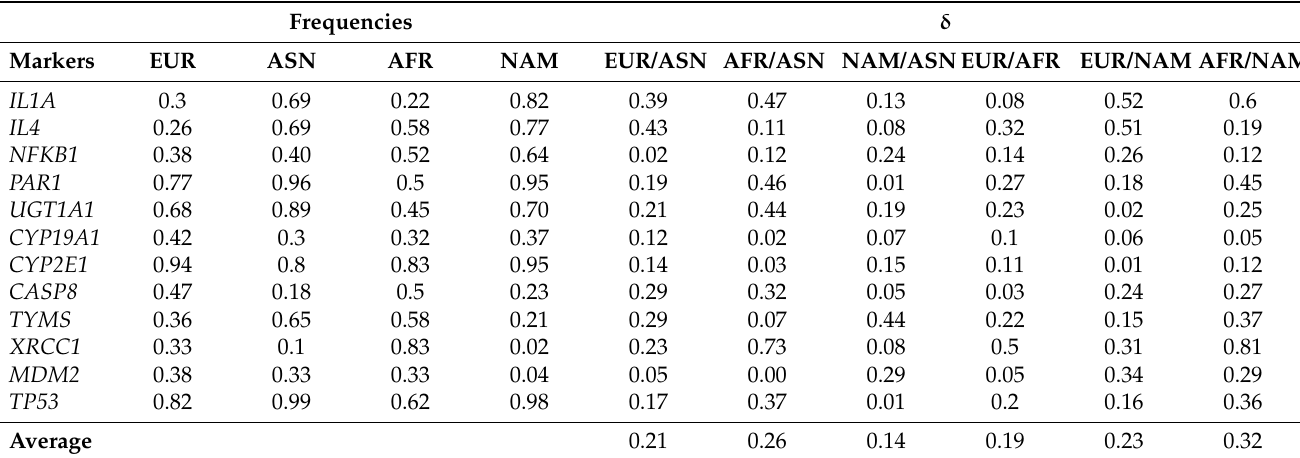
Table 2. Frequency of the shortest alleles of the 12 polymorphisms in the AFR, EUR, NAM and ASN populations, and the mean difference in frequency among populations ( δ values).